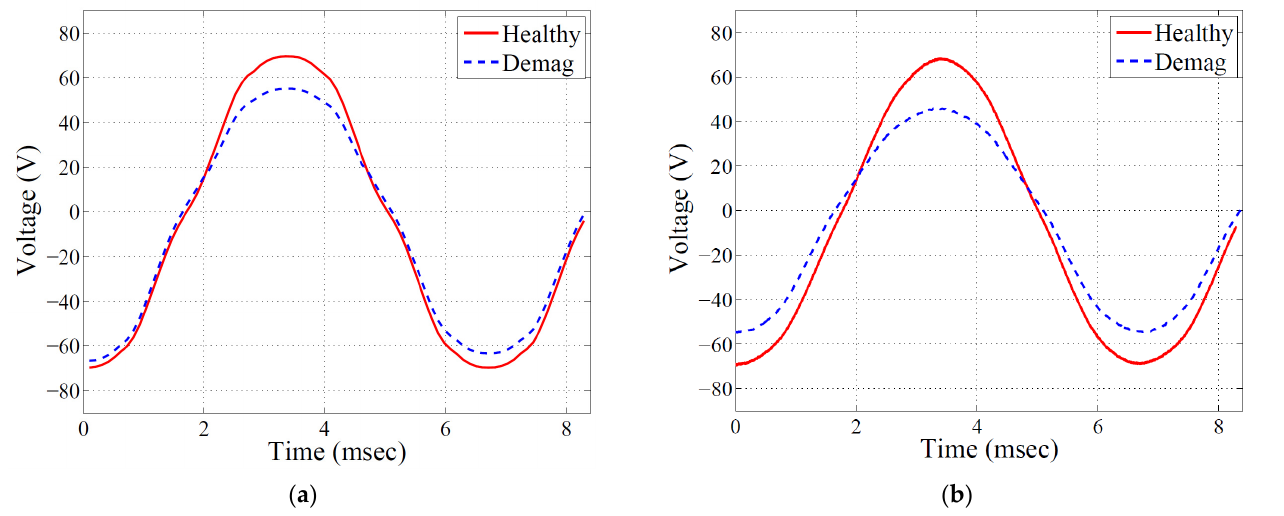
Figure 13. Comparison of the line-to-line back-emf waveforms for the IPM test machine. Both pre-test healthy magnets (solid lines) and demagnetized magnets (dashed line) after the locked-rotor test are shown: ( a ) FE-predicted; ( b ) measured.